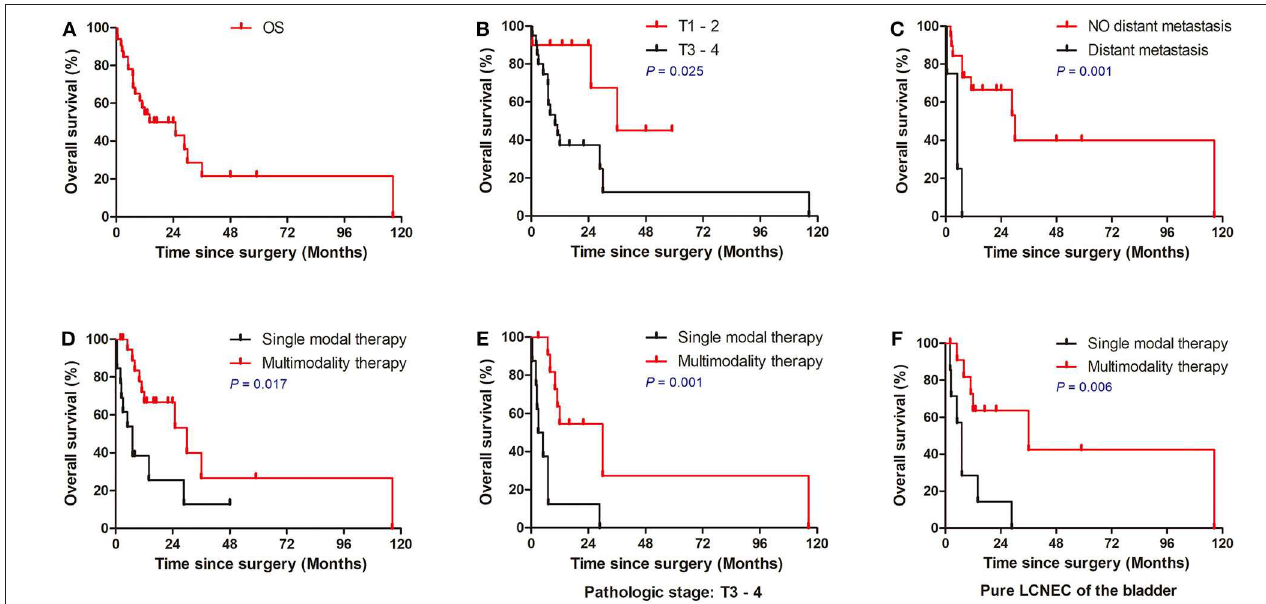
FIGURE 2 | Overall Kaplan–Meier survival curves for patients with LCNEC. (A) Survival of all patients. (B) Survival of patients stratified according to TNM stage. (C) Survival of patients stratified according to T stage. (D) Survival of patients stratified according to M stage. (E) Multimodality therapy vs. single therapy according to pure LCNEC of the bladder. (F) Multimodality therapy vs. Single therapy according to pathologic stage T3–4. LCNEC, large cell neuroendocrine carcinoma; ACT, adjuvant chemotherapy.